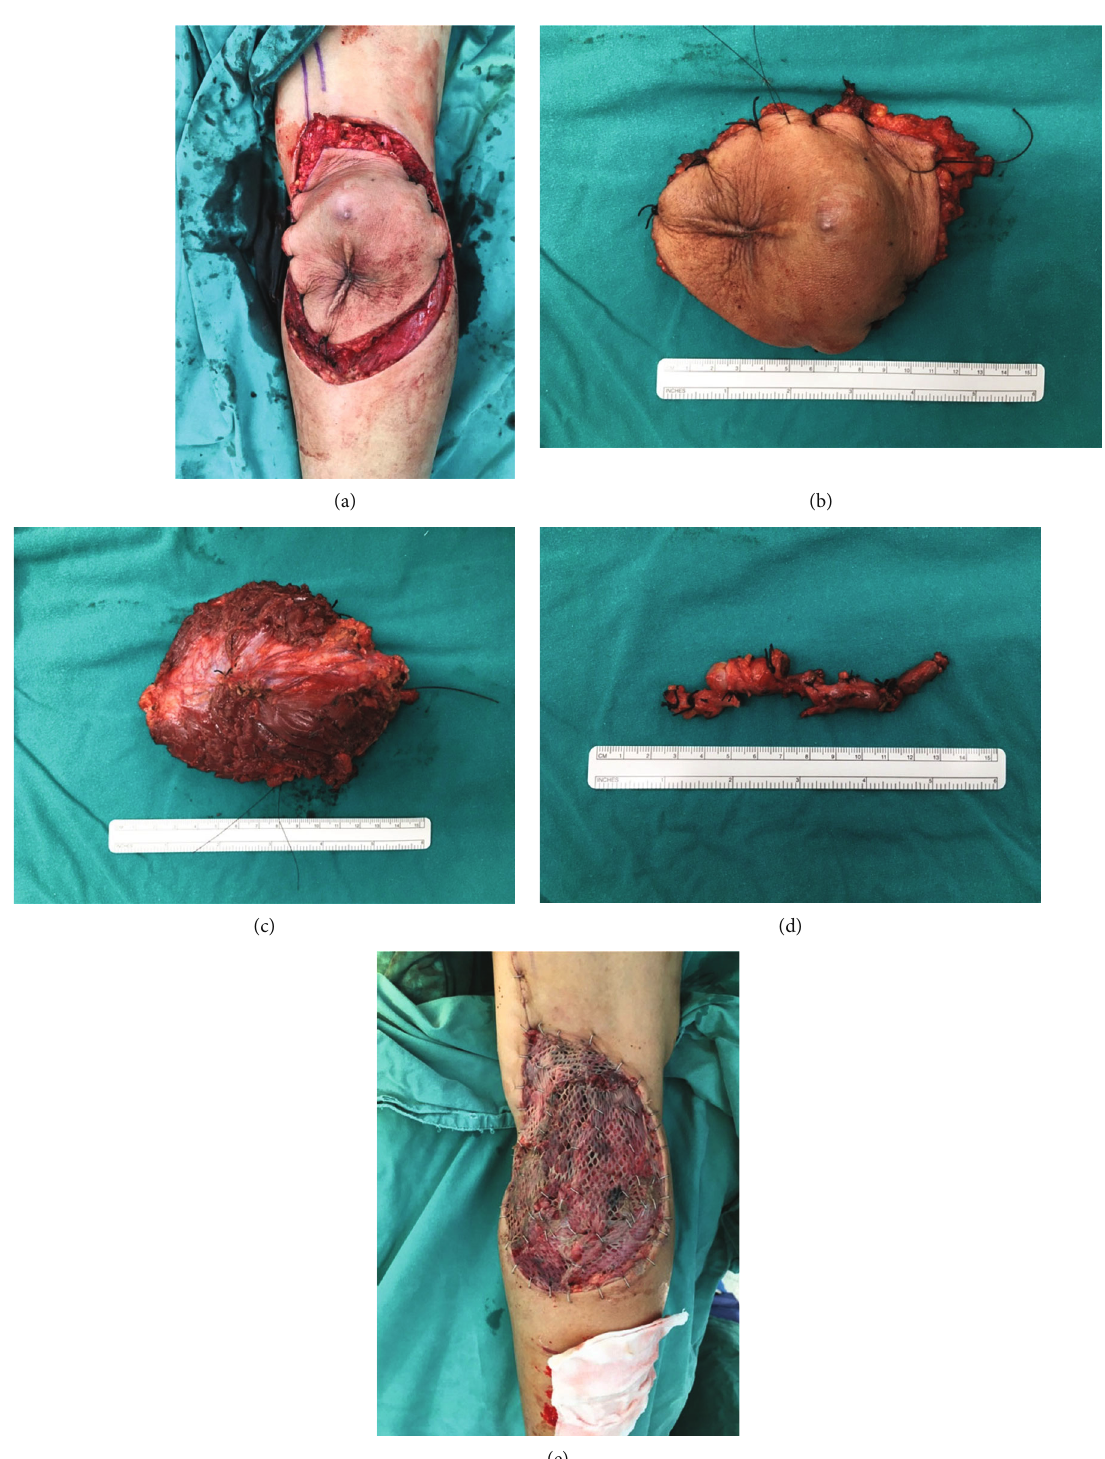
Figure 4: Tumor removal. (a) Incision. (b) Tumor after en bloc excision (super fi cial view). (c) Tumor after en bloc excision (deep margin). (d) Popliteal vein involved by tumor. (e) Surgical wound covered by split-thickness skin